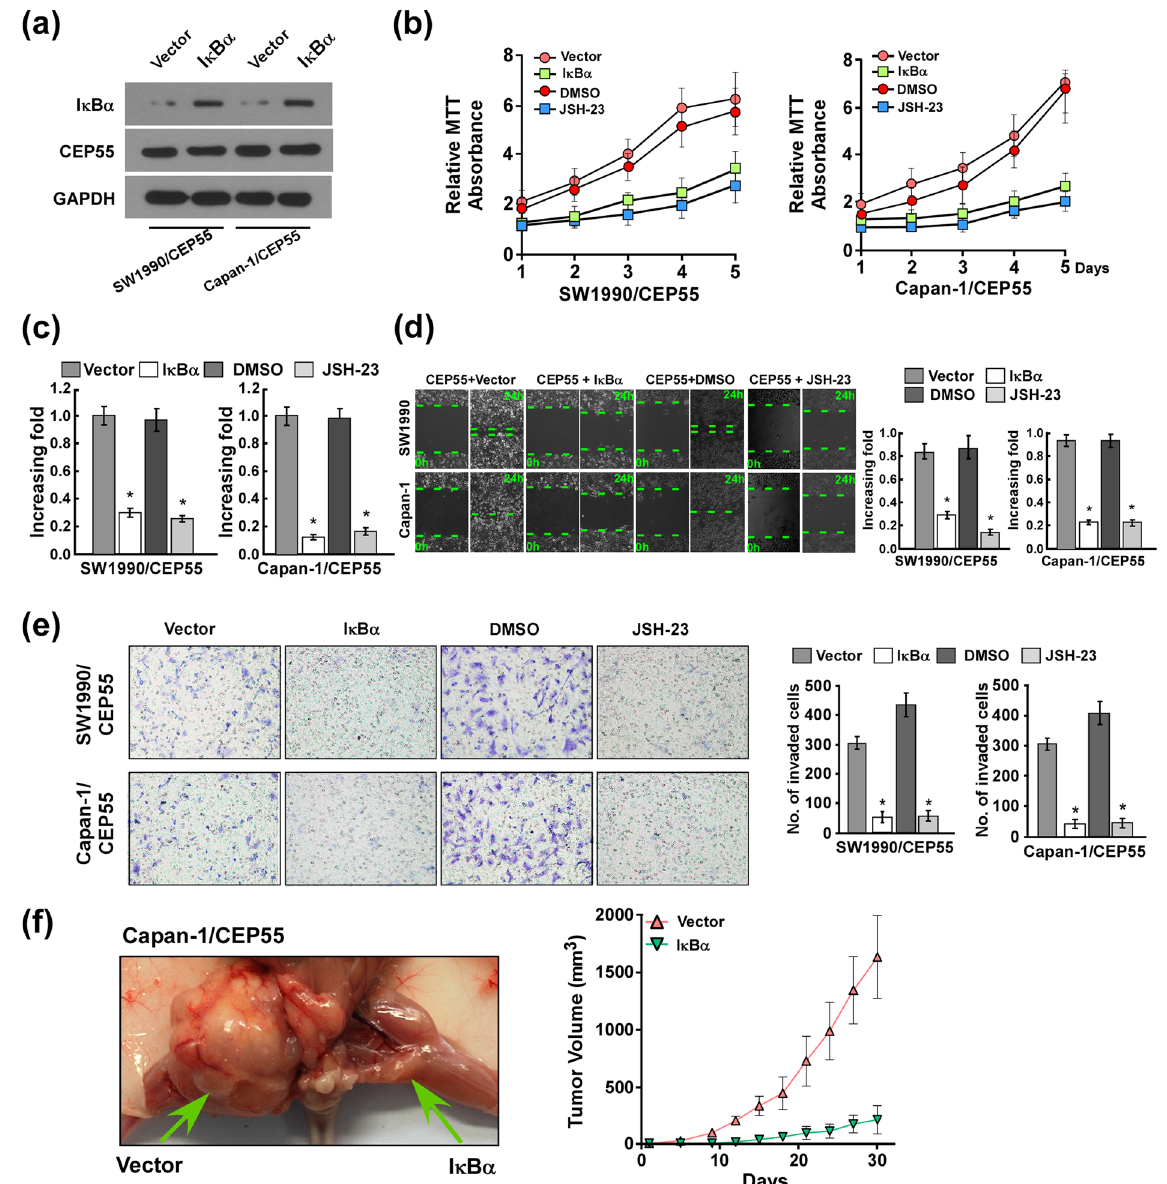
Figure 6. The nuclear factor kappaB (NF- κ B) pathway contributed to CEP55-mediated aggressiveness and tumourigenicity of pancreatic cancer (PANC) cells in vitro and in vivo . ( a ) The protein expression of I κ B α transfected into CEP55-overexpressing PANC cells is detected by western blotting assay. ( b ) MTT assay of CEP55-overexpressing SW1990 and Capan-1 cells transduced with I κ B α or JSH-23. ( c ) Quantification of crystal violet-stained colonies of CEP55-overexpressing SW1990 and Capan-1 cells transduced with I κ B α or JSH-23 after 14 days of colony formation. ( d ) Wound-healing assay assessment of CEP55-overexpressing SW1990 and Capan-1 cell migration after transfection with I κ B α or JSH-23. ( e ) Quantification of CEP55- overexpressing SW1990 and Capan-1 cell invasion in a Transwell matrix penetration assay. The quantification of invaded cells represents the mean of three independent experiments. ( f ) Subcutaneous tumour xenograft model in nude mice; representative images of the tumours formed by CEP55-overexpressing Capan-1 cells transfected with I κ B α (left panel, n = 5). Growth curves for tumour formation after implantation of CEP55-overexpressing Capan-1 cells transfected with I κ B α (right panel). Bars represent the mean ± SD of three independent experiments. * P <